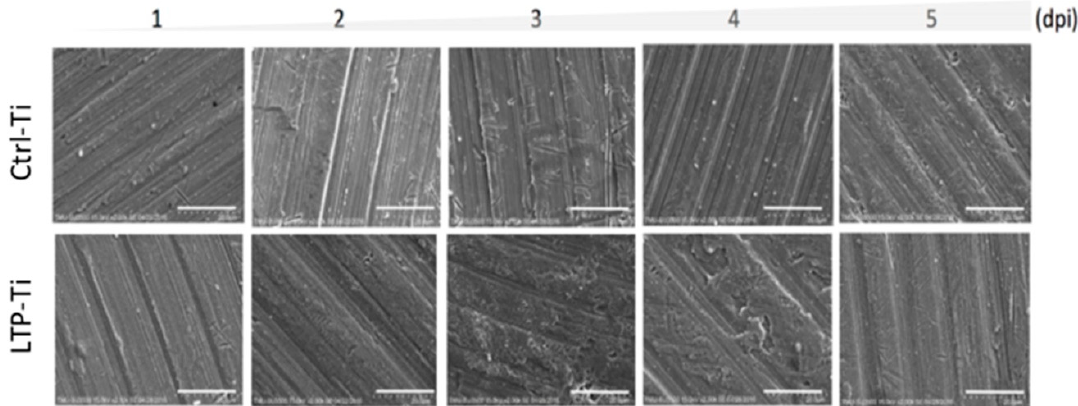
Figure 6. Adhesion of Porphyromonas gingivalis to the surfaces of the titanium disks after treatment. After treatment, each disk was exposed to P. gingivalis (10 6 CFU/mL), cultured for up to 5 d, and harvested at the indicated time points. At 1 d and other time points after exposure, the disks treated with low-temperature plasma (LTP-Ti condition) demonstrated lower bacterial adhesion than the control (Ctrl-Ti) disks. * p < 0.05, ** p < 0.01, *** p < 0.001.